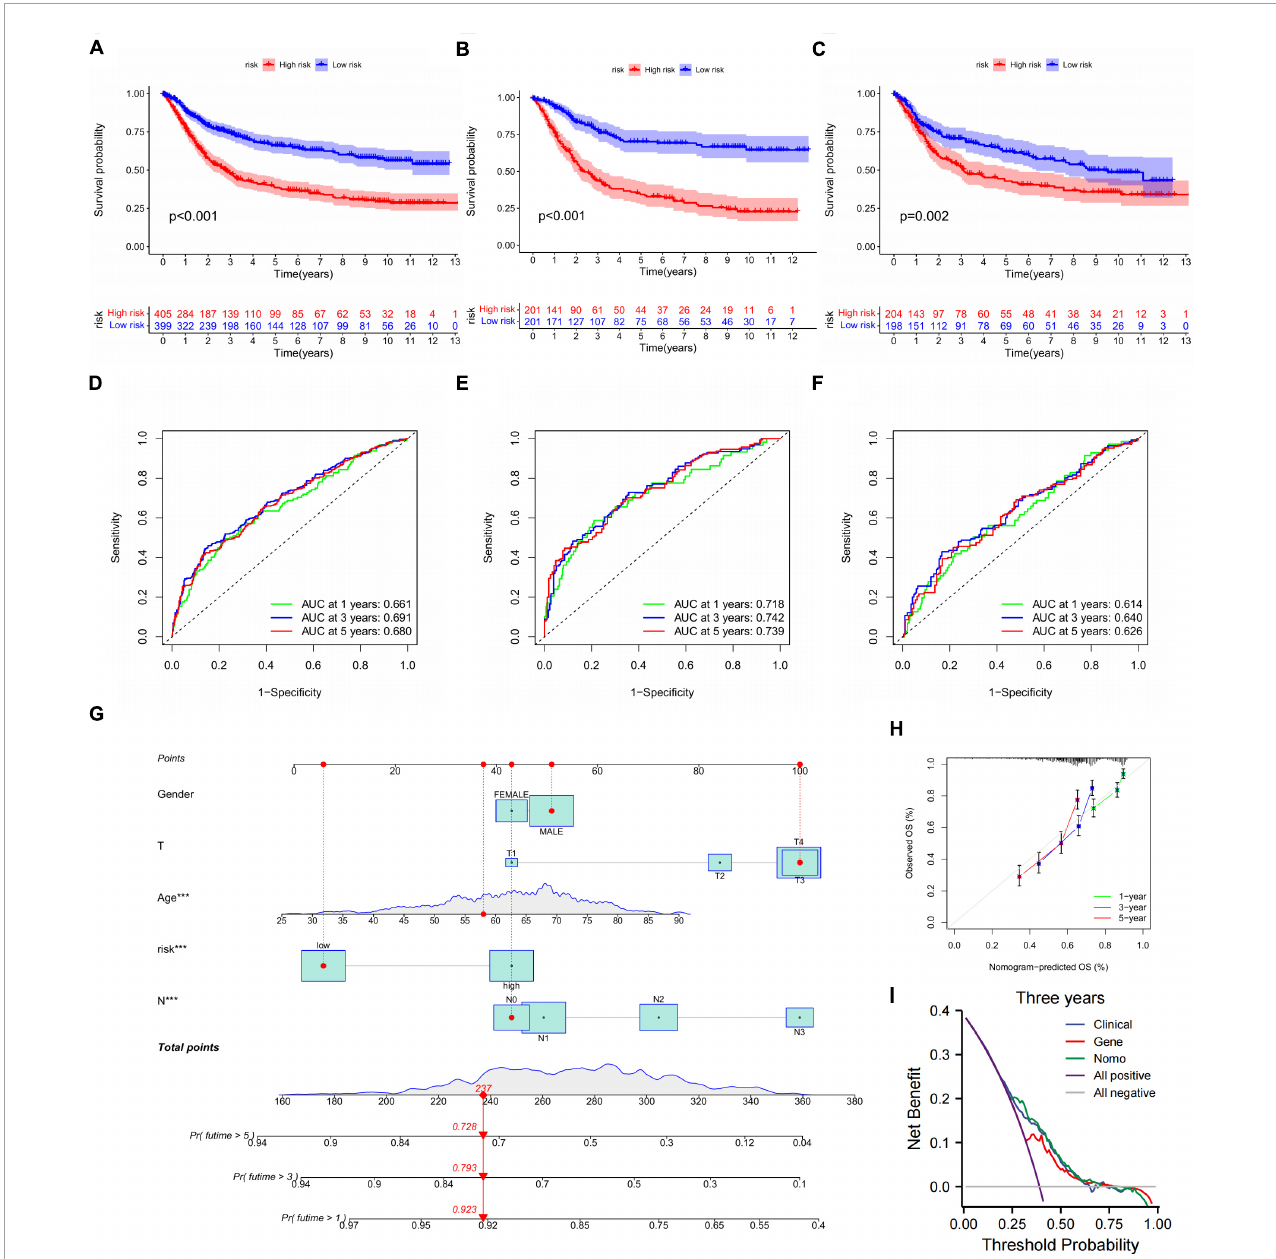
FIGURE8 Validation of the CDEGs-related model. (A–C) The Kaplan–Meier survival analysis of all cohorts, train cohort, and test cohort. (D–F) ROC curves comparing the 1-, 3-, and 5-year overall survival in all cohort, train cohort, and train cohort. (G) Nomogram for predicting the 1-, 3-, and 5-year overall survival in the train cohort, *** p < 0.001. (H) Calibration curves of the nomogram for predicting of 1-, 3-, and 5-year overall survival. (I) DCA curves for two independent prognostic factors or a combination of them in OS prediction. CDEGs, cancer associated fibroblast related differential